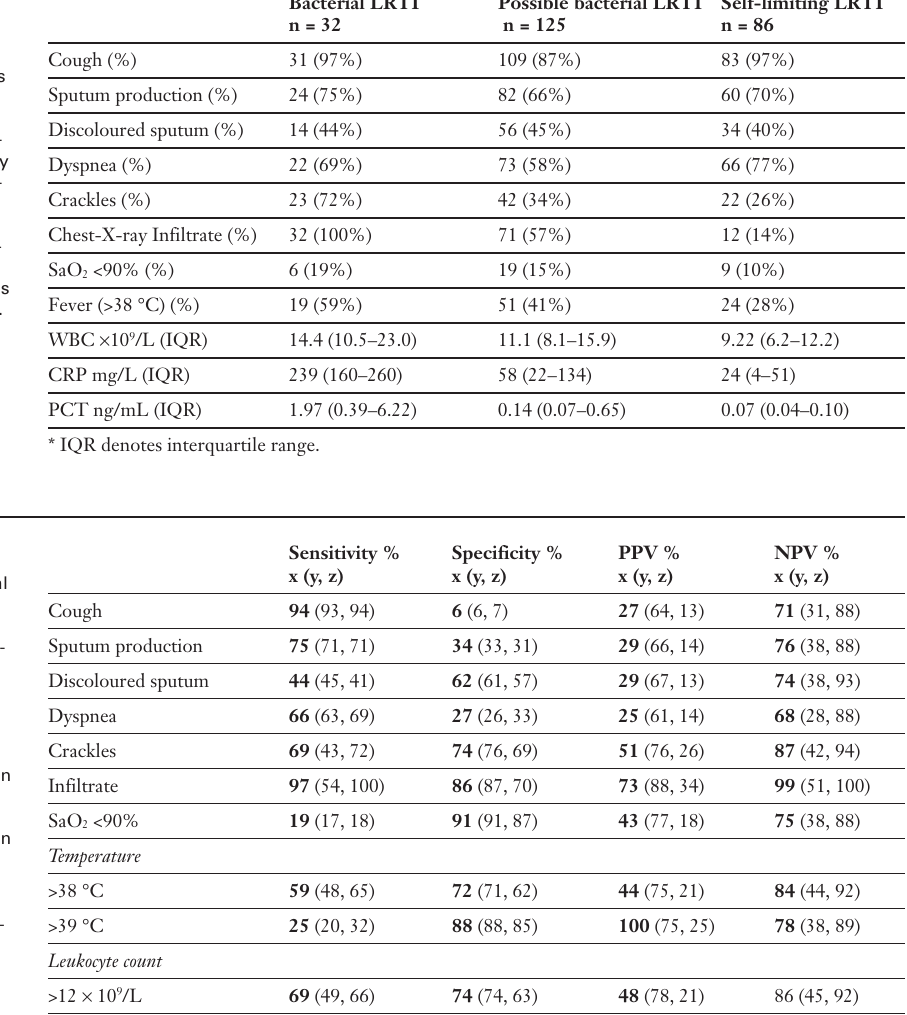
Table 2 Clinical and labora- tory parameters in the group of patients with bacterial lower respiratory tract in- fection (LRTI) requir- ing antibiotic therapy (bacterial LRTI), pos- sible bacterial LRTI and self-limiting LRTI. Values are per- centages (absolute numbers) or medians (interquartile range).